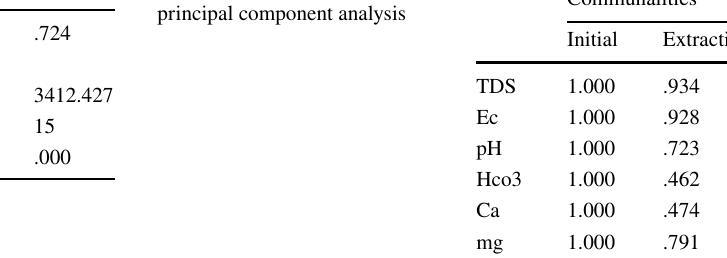
Table 3 KMO test